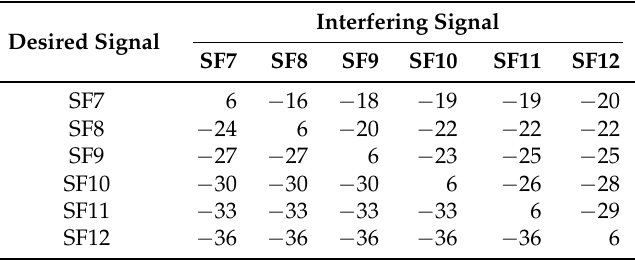
Table 2. Thresholds of Signal-to-Interference Ratio (SIR) (values in dB) for all spreading factor combinations of the desired and interfering signals